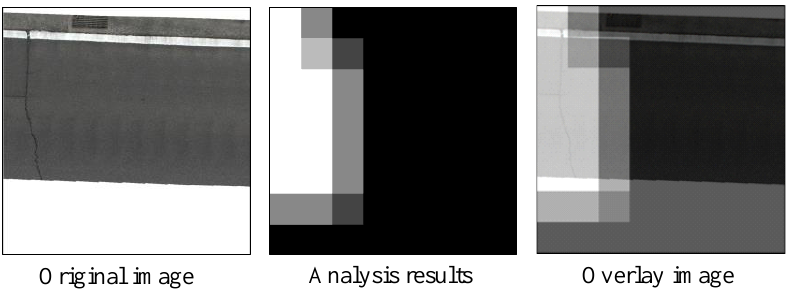
Figure 9. Improvement of the analysis results with an increase in the number of steps.